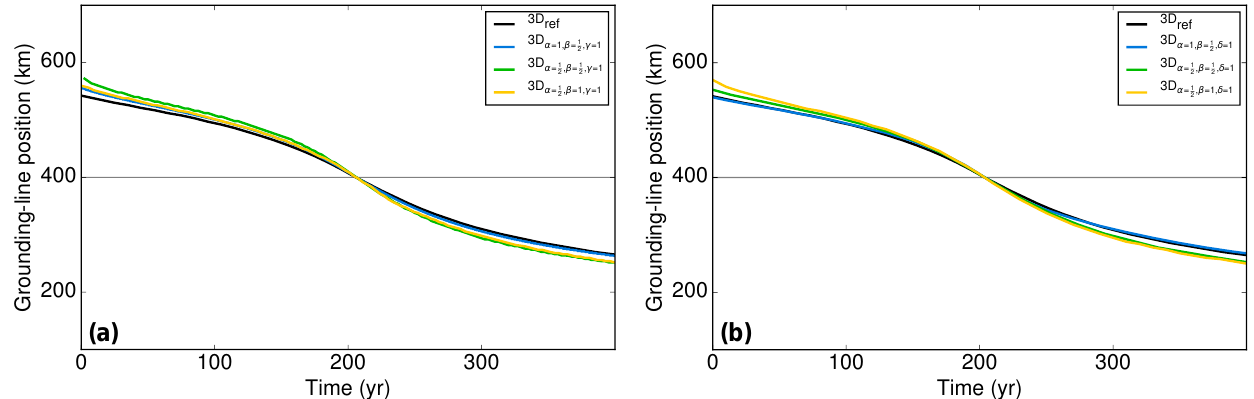
Figure D2. Scaled time series of centerline grounding-line position (along y = 0) for the reference and three geometrically scaled 3-D channel experiments with (a) identical basal friction and (b) identical surface mass balance, respectively (analogous to Fig. D1). See Fig. 6 for unscaled version of this